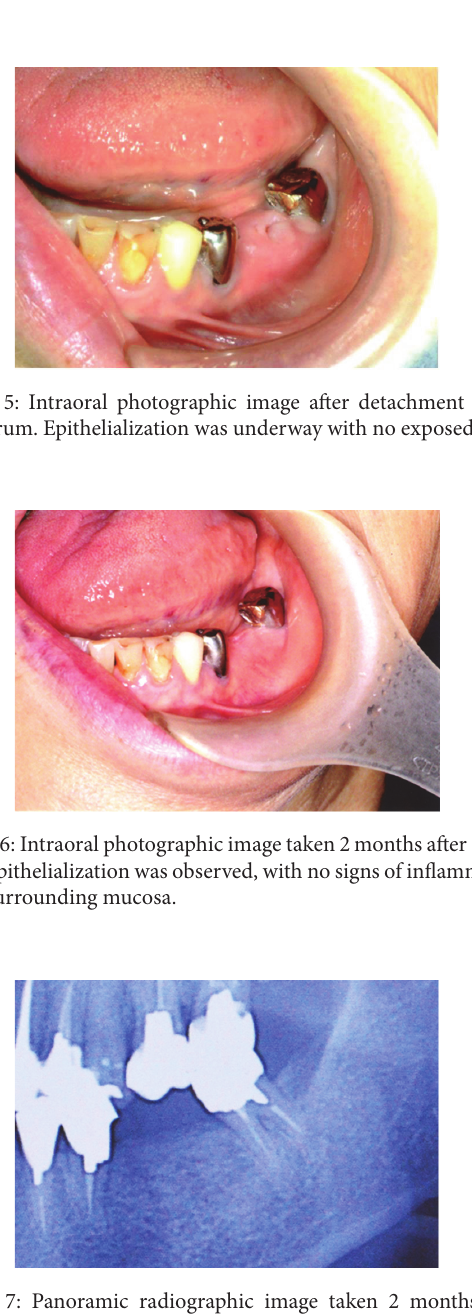
Figure 7: Panoramic radiographic image taken 2 months after exfoliation. No recurrence of bone formation was observed.